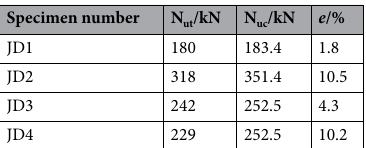
Table 7. Comparison of ultimate bearing